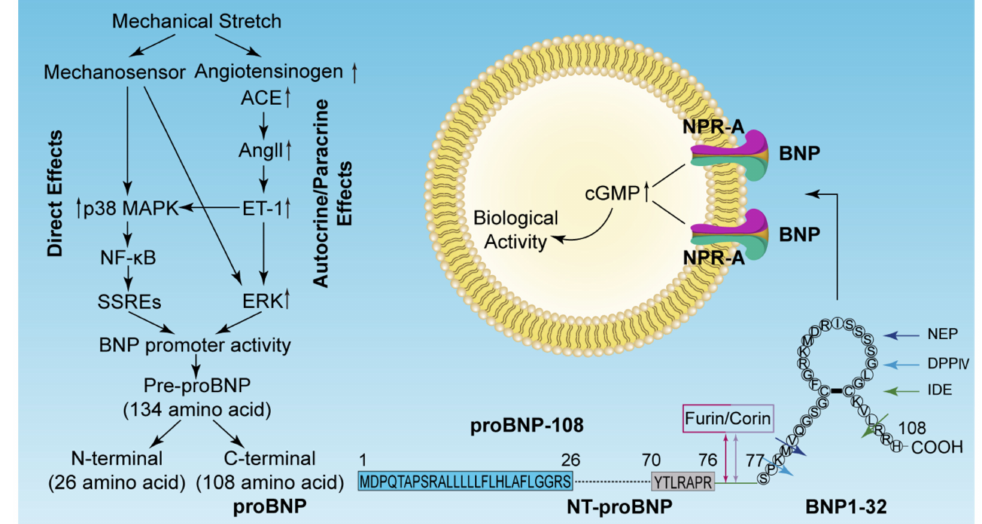
Figure 1. Diagrammatic sketch of mechanical stretch inducing brain natriuretic peptide (BNP) signal transduction events, structural processing, receptor binding, cleavage processing, and degradation enzymes (modified from [36,43] with